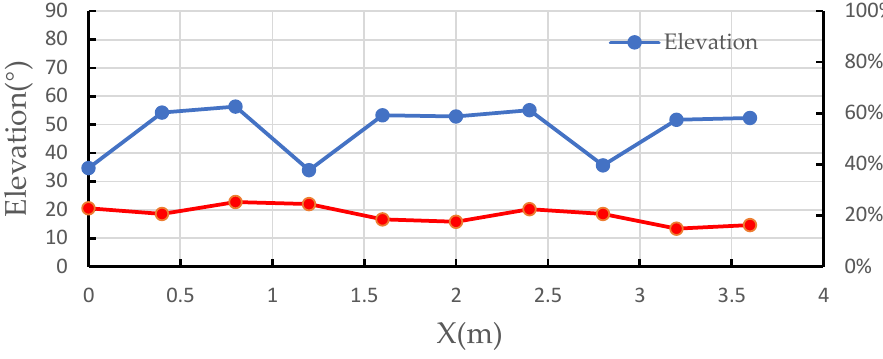
Figure 27. Elevation curve of the transmission line relative to the sensor array.